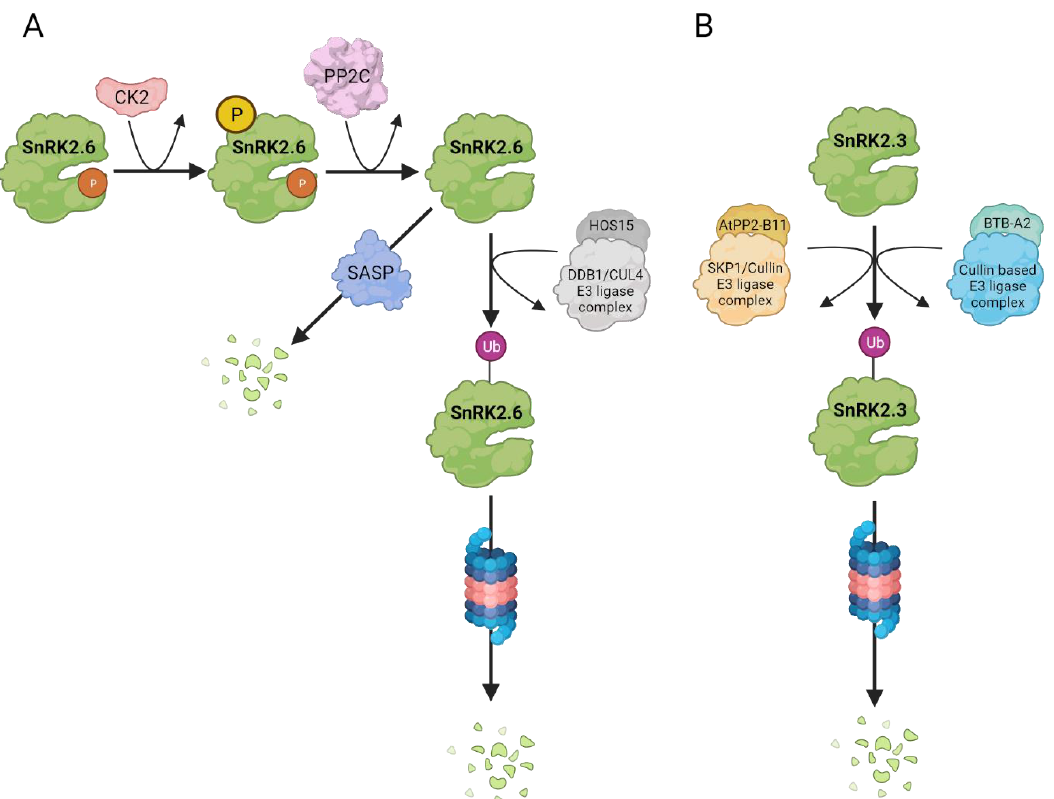
Figure 4. Controlled degradation of SnRK2s in Arabidopsis. ABA-responsive SnRK2s undergo degradation in a kinase- specific manner via proteasomal degradation pathway as well as by specific proteases. ( A ) SnRK2.6 ubiquitination occurs when the kinase is in an inactive, dephosphorylated state. The kinase interacts with HIGH OSMOTIC STRESS 15 (HOS15), a CULLIN4 (CUL4)-DAMAGED DNA BINDING PROTEIN1 (DDB1)-based E3 ubiquitin ligase and is targeted to degradation via Ubiquitin Proteasome System (UPS). Phosphorylation of SnRK2.6 within the ABA-box, catalysed by Casein Kinase 2 (CK2), promotes SnRK2.6 degradation by enhancing its interaction with and dephosphorylation by clade A PP2Cs, and thus interaction of SnRK2.6 with HOS15. Additionally, SnRK2.6 protein level is regulated via Senescence-Associated Subtilisin Protease (SASP). ( B ) SnRK2.3 stability is negatively controlled by PHLOEM PROTEIN 2-B11 (AtPP2-B11), an F-box component of the SKP1 (S PHASE KINASE-ASSOCIATED PROTEIN 1)/Cullin/F-box E3 ubiquitin ligase complex as well as Broad-complex, Tramtrack, and Bric-a-brac proteins, namely BTB-A2.1, BTBA2.2, and BTB-A2.3, substrate adaptors for cullin-based E3-ligases. The ubiquitinated kinase is degradated by UPS.